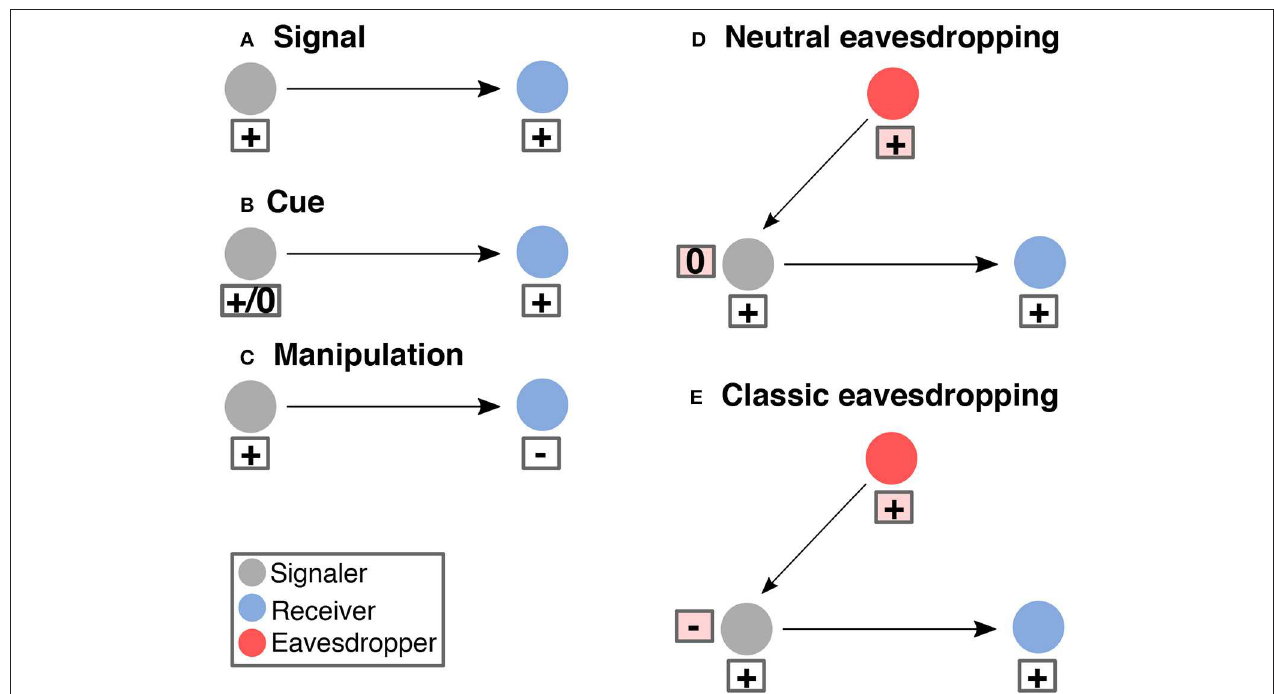
FIGURE 1 | Different kinds communication systems. A signal is produced by a signaler to obtain a response from a receiver (A) . Both signaler and receiver benefit from this interactions. Cues are unintended information that can be useful for the receiver (B) . A signaler can also exploit sensory biases in the receiver to obtain a benefit at the cost of this receiver (C) . Eavesdroppers intercept a signal to obtain beneficial information for them (D,E) often at the cost of the signaler (E)